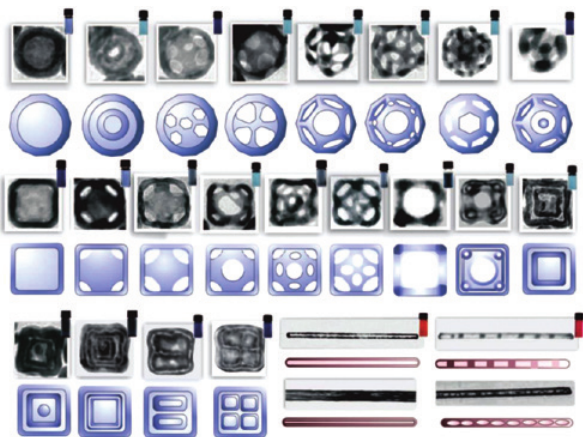
Figure 4: TEM images and schematic representation of the different morphologies produced by the simultaneous or sequential action of galvanic replacement reaction and the Kirkendall effect (adapted with permission from Ref. [19], copyright 2011 The American Asso- ciation for the Advancement of Science).